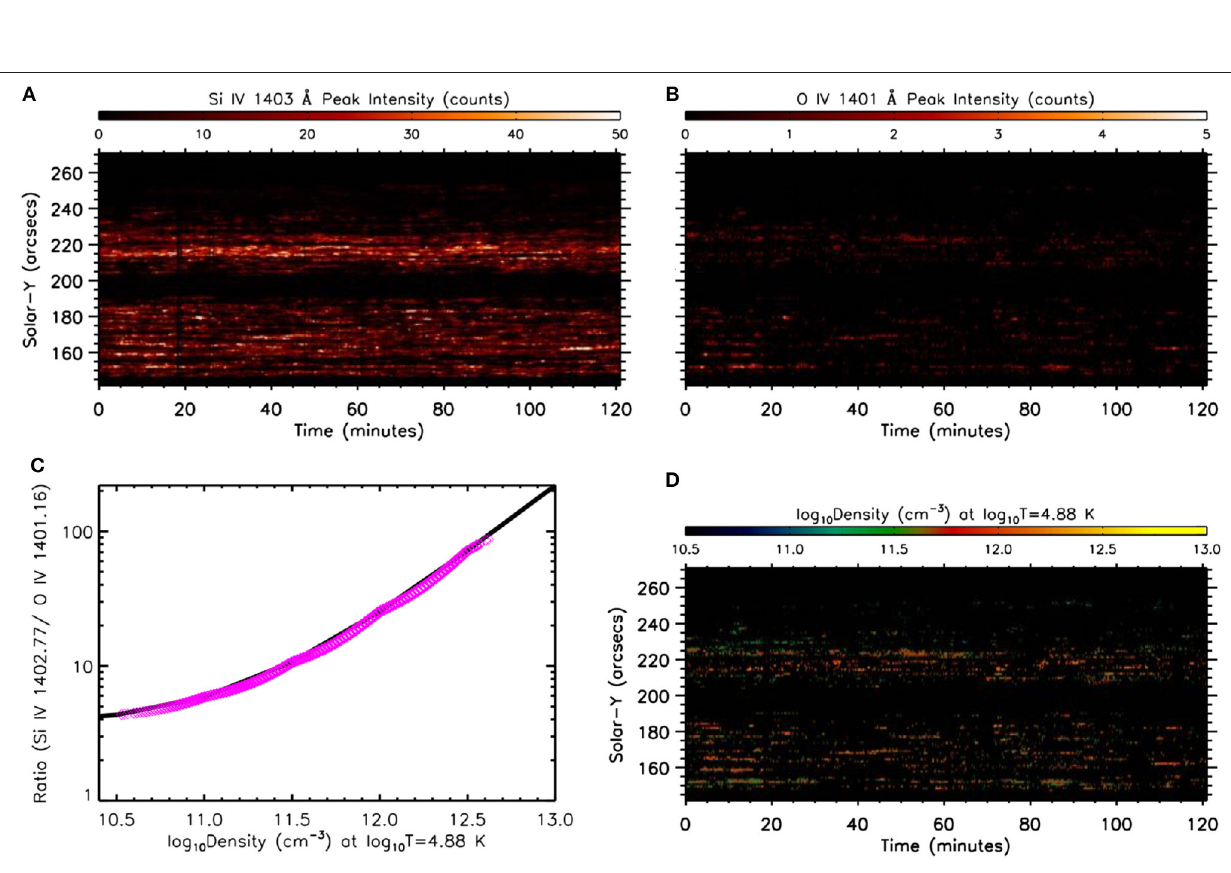
Frontiers in Astronomy and Space Sciences |